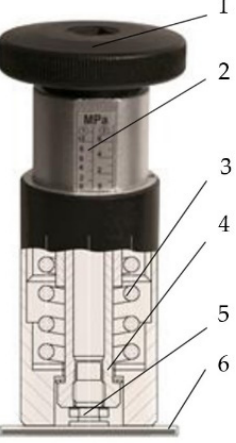
Figure 4. Konstanta AC adhesion gauge: 1—upper handle; 2—scale; 3—spring; 4—grip; 5— mushroom knob; 6—coating.